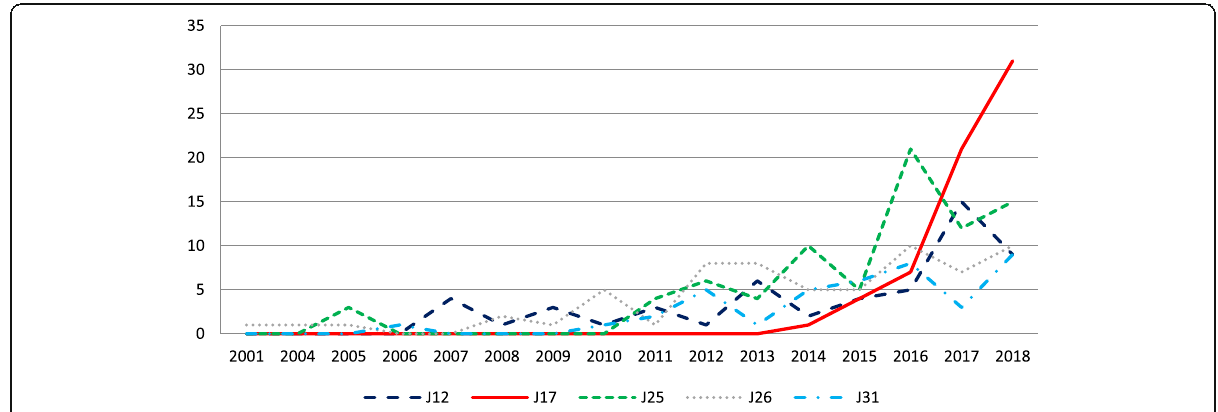
Fig. 7 Publication distribution of selected five journals over the years. (Note: J12: International Journal of Engineering Education; J17: International Journal of STEM Education; J25: Journal of Science Education and Technology; J26: Journal of STEM Education; J31: School Science and